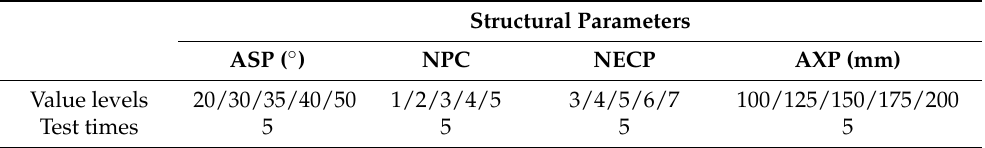
Table 2. Single-factor experimental design of structural parameters.